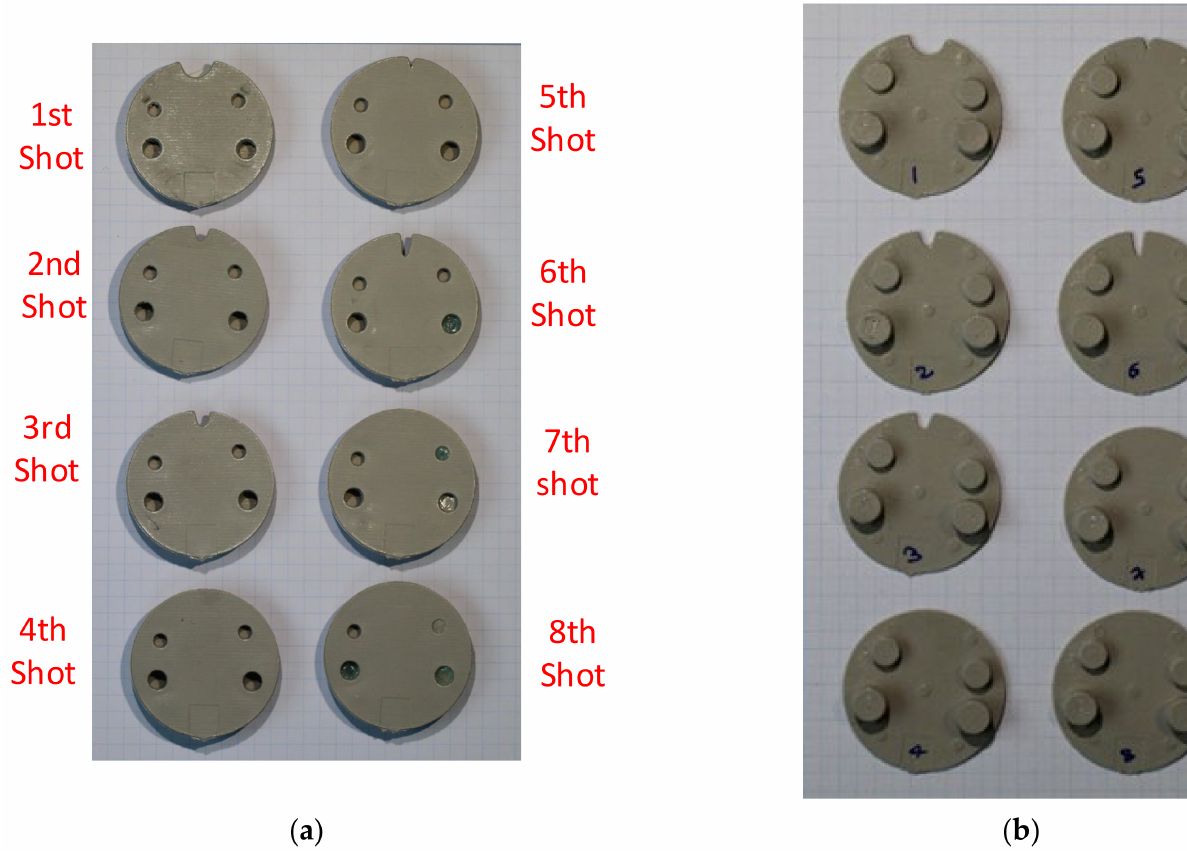
Figure 31. ( a ) Core face of the moulded part showing signs of progressive deterioration; ( b ) cavity side of the moulded showing no signs of progressive deterioration (moulded using insert